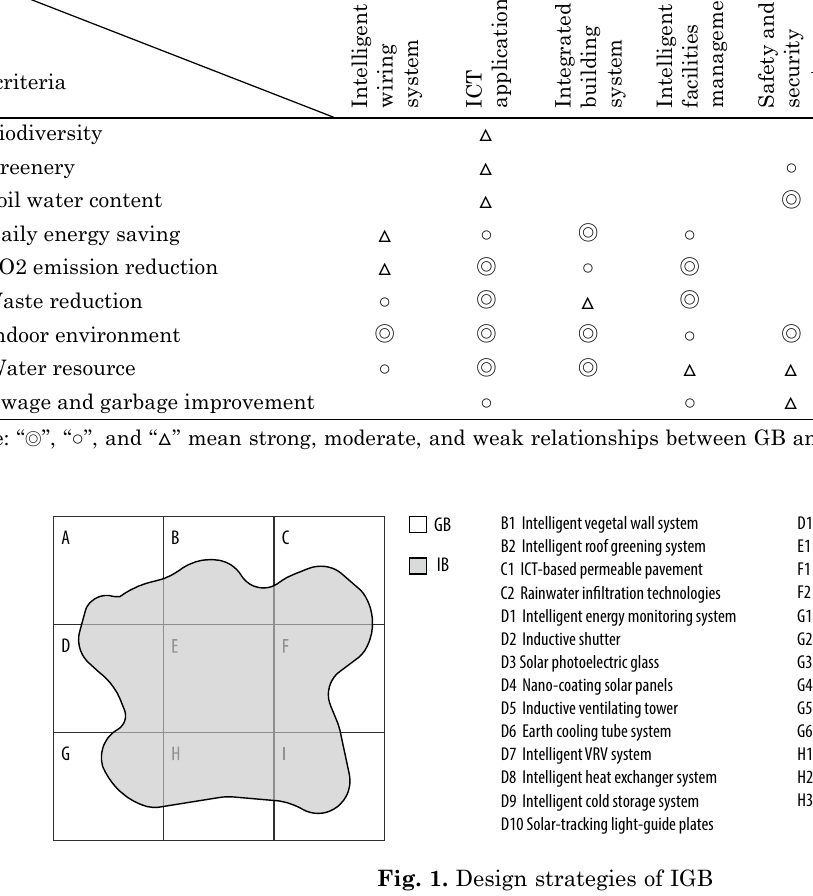
Table 1. IB–GB criteria matrix (ABRI 2003; ABRI 2011) IB criteria